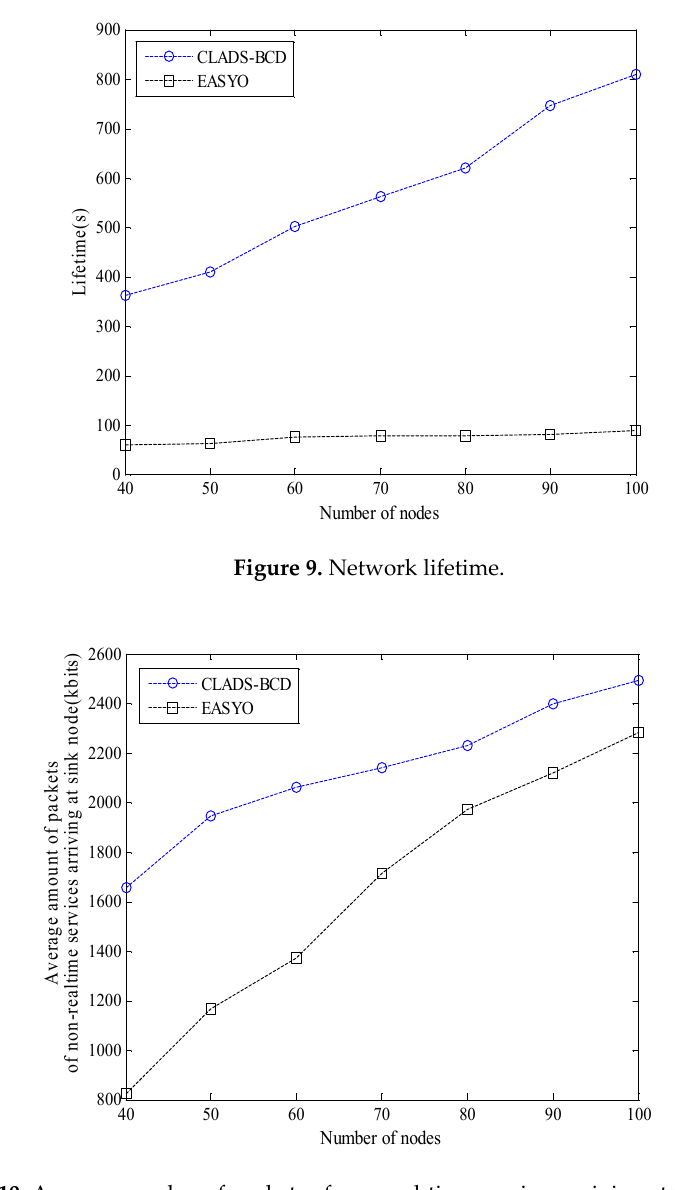
Figure 10. Average number of packets of non-real-time services arriving at the sink